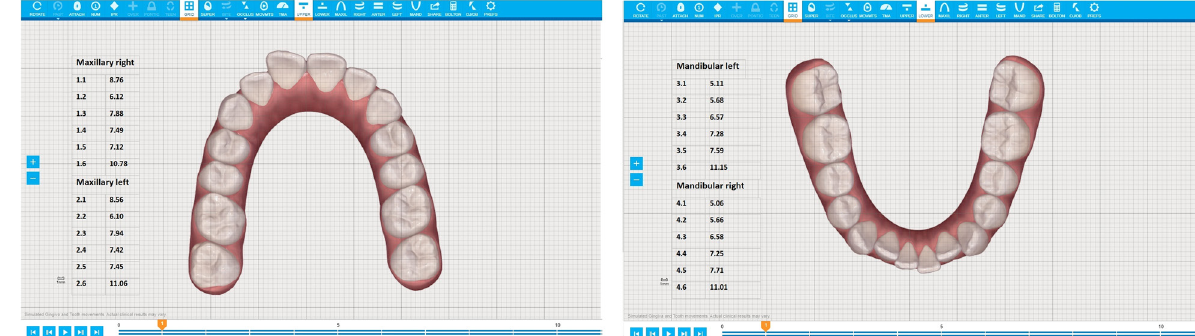
Figure 1. Invisalign technology displaying upper and lower arch with Mesiodistal dimensions of permanent teeth (300dpi).